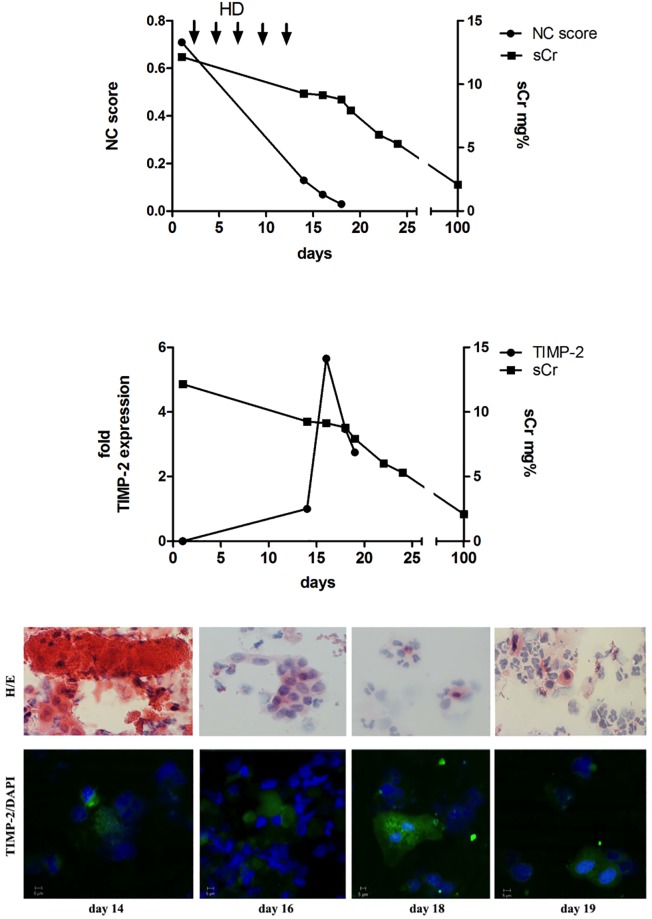
NC score, sCr, normalized fold TIMP-2 expression and staining of urinary sediment of representative patient #1.A) A representative patient after kidney transplantation, but requiring haemodialysis (HD) throughout the first week post-transplant (DGF). Improvement of renal function was accompanied by an increase of urinary sediment TIMP-2 expression, and decrease in NC score parameter. 100 days after kidney transplantation the patient was alive with a serum creatinine of 2.1 mg/dL. B) HE (upper panel) and confocal immunofluorescence staining (lower panel) of urine sediment from the representative patient with delayed graft function. Many morphologically disintegrated cells including casts appeared in urine (day 14). This changed rapidly the following days, cell number in urine increased from day 14 to day 17. Furthermore, the percentage of TIMP-2 positive staining cells increased with presence of a mitosis (day 18) while the number of disintegrated cells decreased, accompanied by rapid fall in NC-score and decrease in sCr.